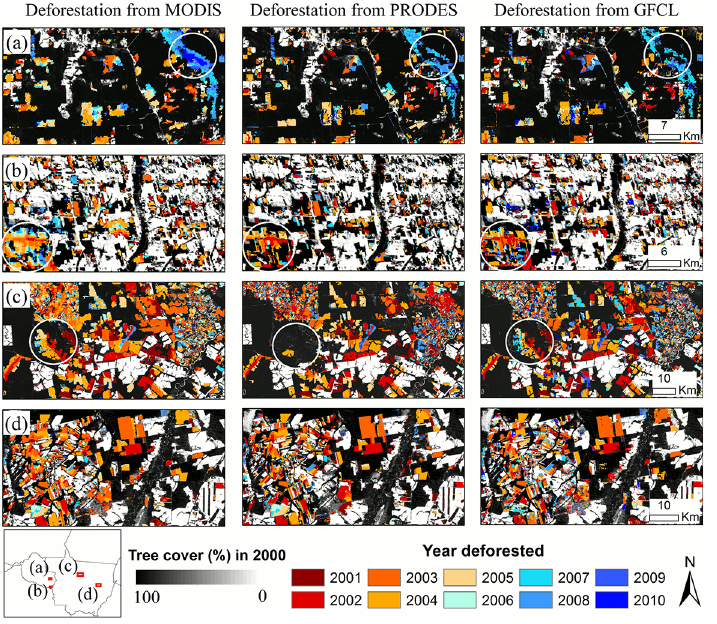
Fig 4. Comparing annual deforestation derived from MODIS with Landsat-based maps in the Brazilian Amazon. The left column is MODIS results from this study, the middle column is PRODES (Program for the Annual Estimation of Deforestation in the Brazilian Amazon) and the right column is GFCL (Global Forest Cover Loss). The spatiotemporal patterns of deforestation agree remarkably well in these products with some disagreement highlighted in circles. (a) Deforestation near Pimenta Bueno, Rondonia (60.821W, 12.088S); (b) Deforestation to the south of Colorado do Oeste in Rondonia (60.754W, 13.396S); (c) Forests cleared for agriculture in central Mato Gross (55.974W, 11.466S); (d) Deforestation to the south of indigenous reserves in the lower Xingu river basin in Mato Grosso (53.033W, 13.158S). The MODIS map likely omits cleared patches below the 250 m pixel size and it also tends to overestimate deforestation over small but inter- connected patches (b). The two Landsat-based products have an advantage to real small-patch clearings, but may overlook some deforestation due to missing data from e.g. cloud contamination (a and c).